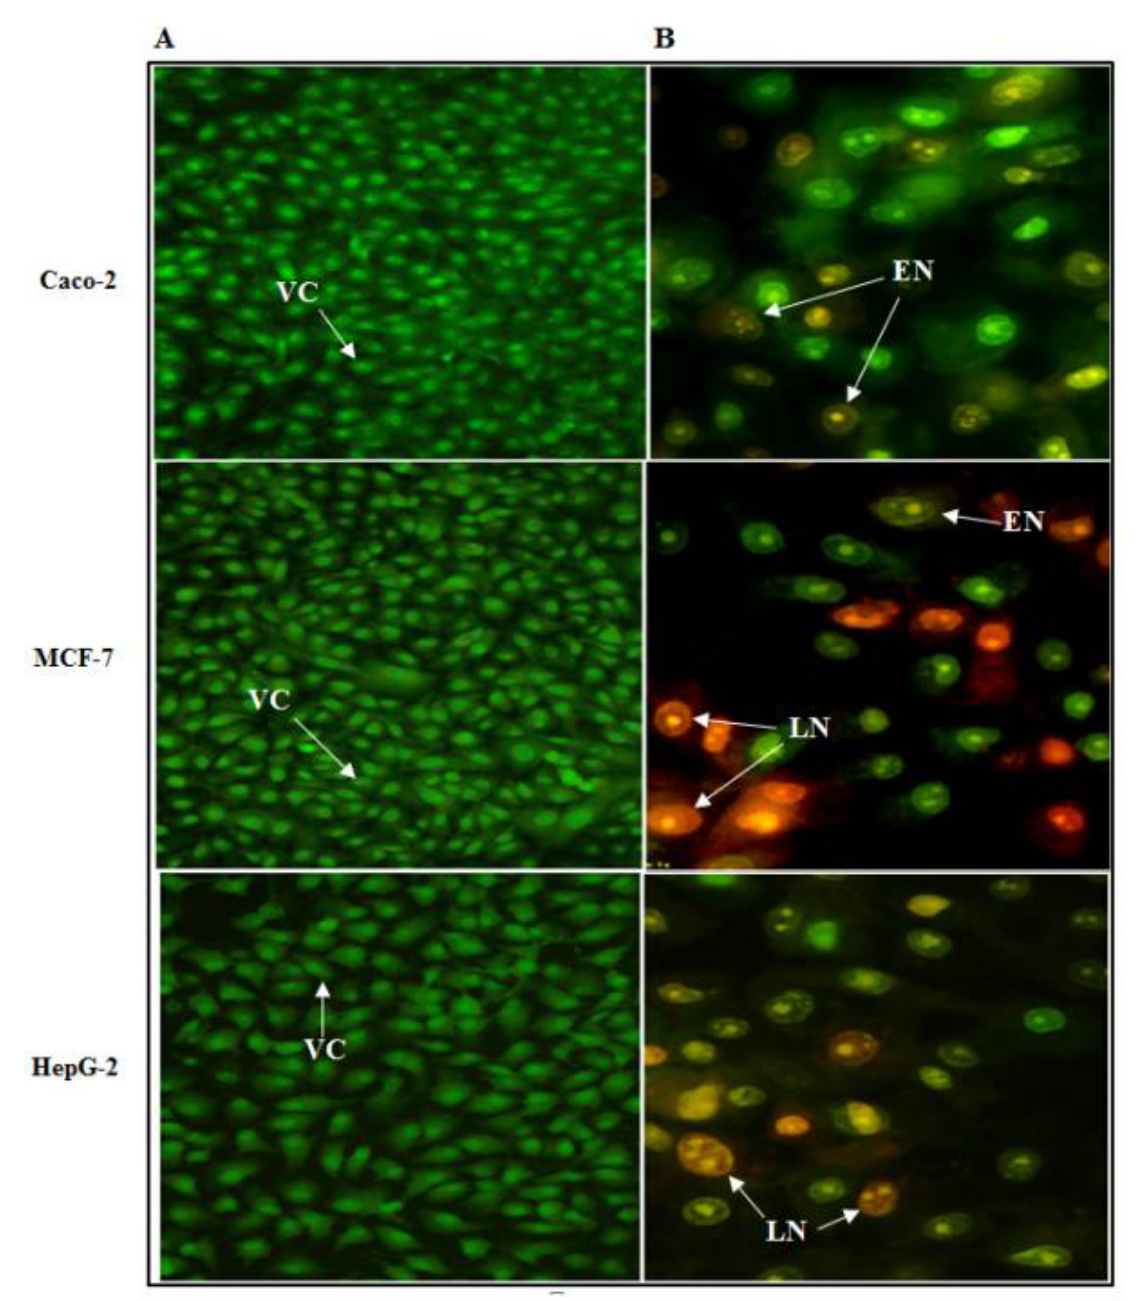
Figure 13. Fluorescence microscopy images of Caco-2, HepG-2 and MCF-7 cells stained with EtBr/AO dye mix. ( A ) Untreated control cells and ( B ) cells after 72 h treatment with the IC 50 of cell-free synthesized human TNF-α protein. VC: Viable cells, EN: early necroptotic cells and LN: late necroptotic cells (magnification × 400).